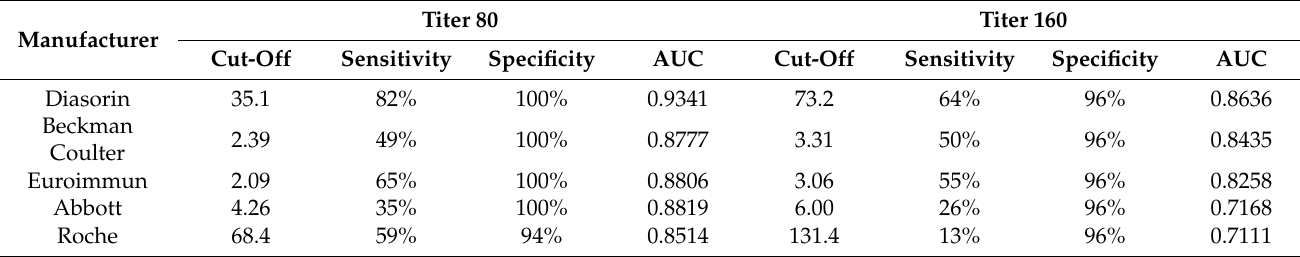
Table 5. Cut-off value with sensitivity and specificity for VNT titer 80 and 160.